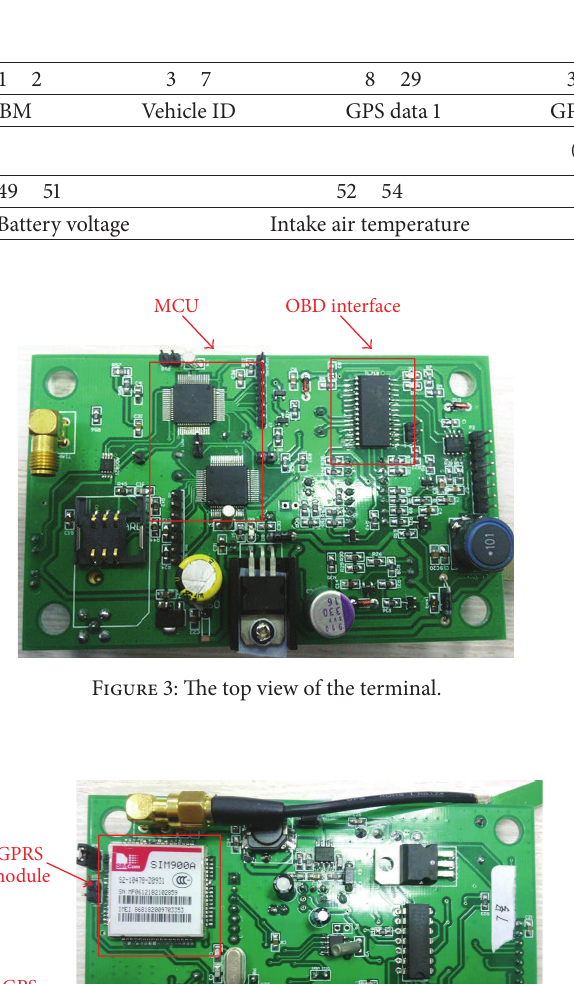
The server will receive three kinds of data packets, each of which has different frame formats.